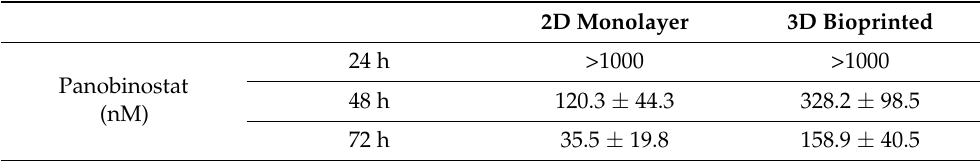
Table 2. IC 50 values of human kidney fibroblast treated with panobinostat in 2D culture or 3D constructs.